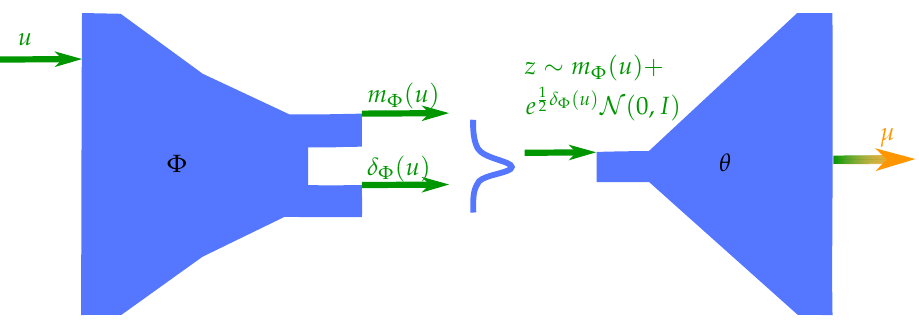
Figure 1. Schematical representation of the classical